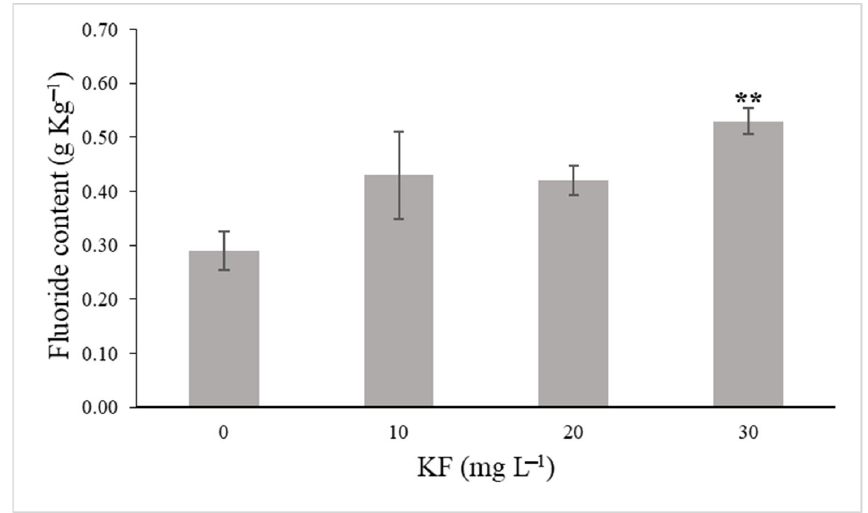
Figure 1. Fluoride (F) content in Lactuca sativa L. leaves after 40 days of exposure to 0 mg L − 1 , 10 mg L − 1 , 20 mg L − 1 , and 30 mg L − 1 potassium fluoride (KF). Data represent the means ± SE (n = 4). Asterisks indicate significant differences at 1% (**) probabilities between the KF treatments and the control group according to the Dunnett